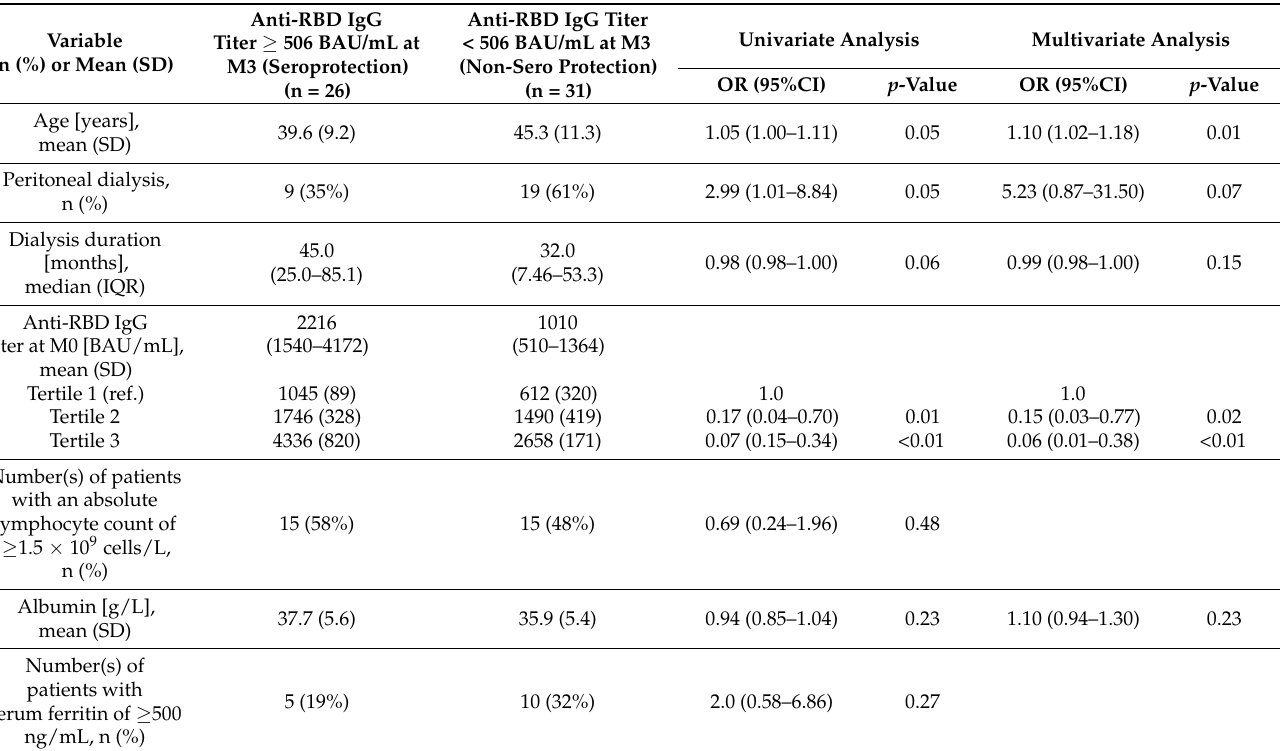
Table 2. Baseline characteristics and predictors of anti-RBD IgG seroprotection loss (anti-RBD IgG titer below 506 BAU/mL) at 3 months (M3) after an additional dose of the ChAdOx1 nCoV-19 vaccine among 57 patients undergoing